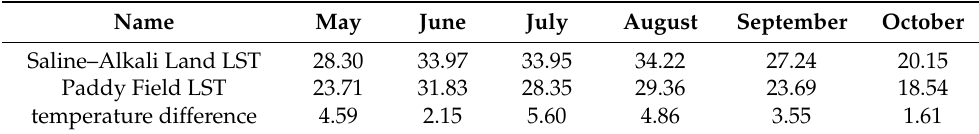
Figure 5. Seasonal variation of surface temperature ( ◦ C) in saline–alkali land ( a ) and paddy fields ( b ) in Da’an City, western Jilin. The error bars in the figure represent the standard deviation. Table 2. Seasonal surface temperature difference ( ◦ C) between saline–alkali land and paddy fields in the growing season.